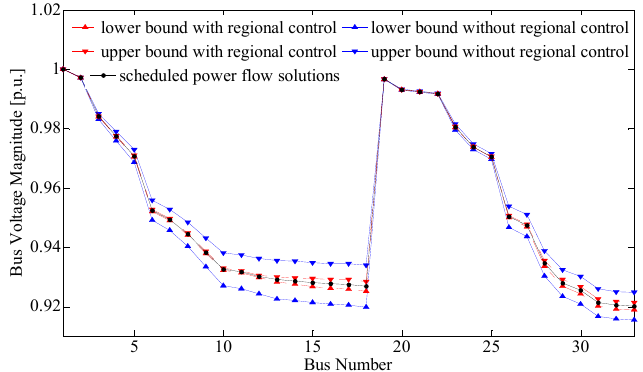
Figure 4. Voltage magnitude bounds in modified IEEE 33-bus distribution system. Energies 2017 , 10 , 1794